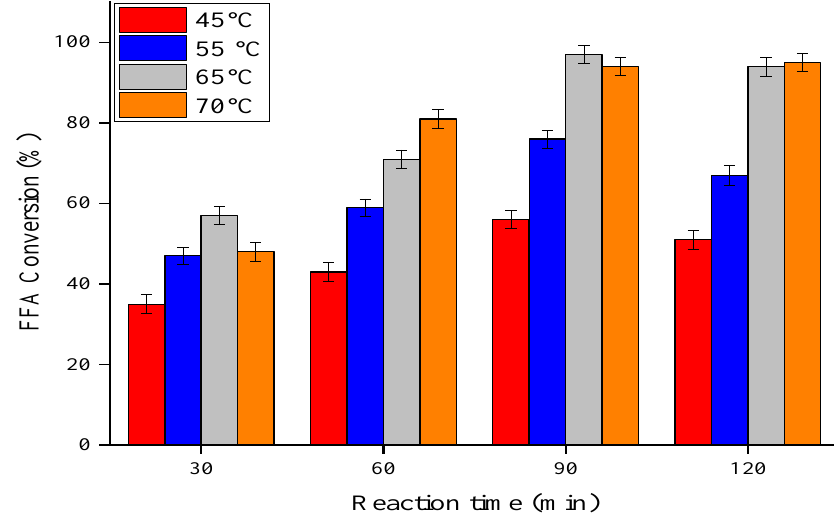
Figure 7. E ff ect of reaction temperature on FFA Figure 7. Effect of reaction temperature on FFA conversion.